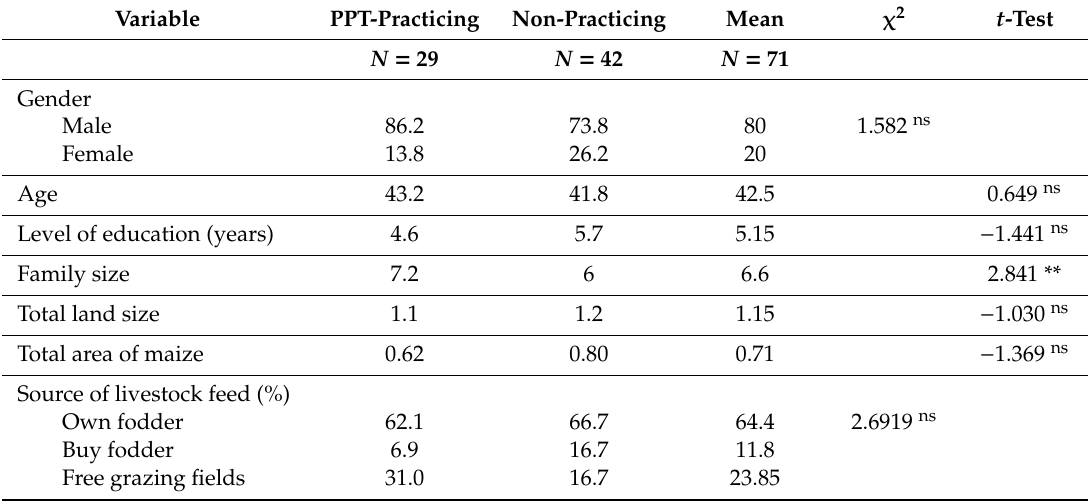
Table 1. Socio-economic characteristics of the respondents in the Hawassa district, Ethiopia.